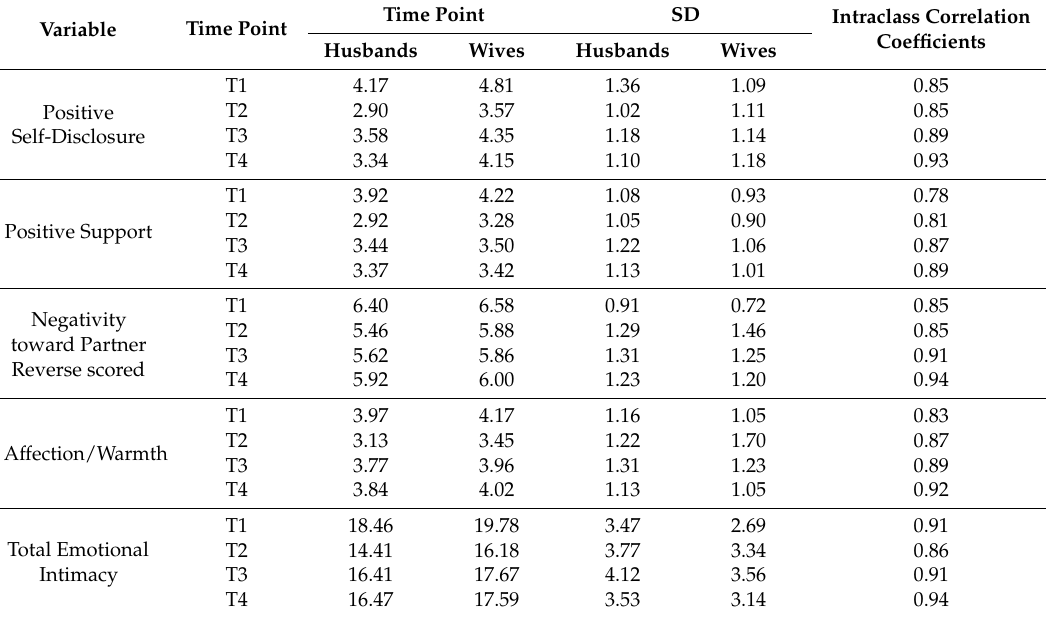
Table 1. Descriptive Information for Predictor Variable: Observed Emotional Intimacy.